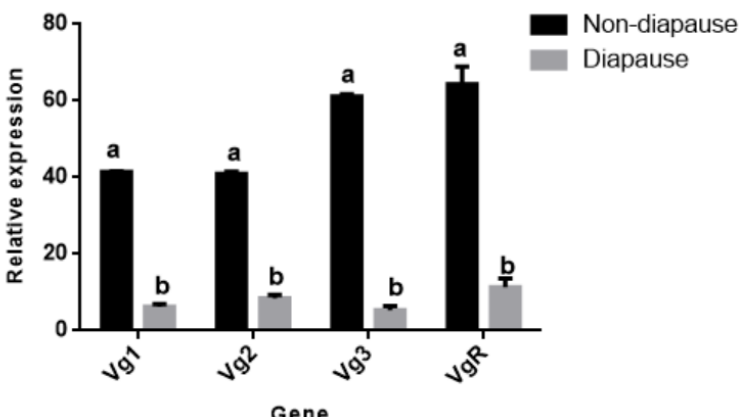
Figure 10. Expressions of N. barkeri Vgs and the VgR in non-diapause and diapause periods. Data are presented as the mean ± standard error (n = 3). Different lowercase letters indicate significant differences (one-way ANOVA with Duncan new multiple range method, p < 0.05).